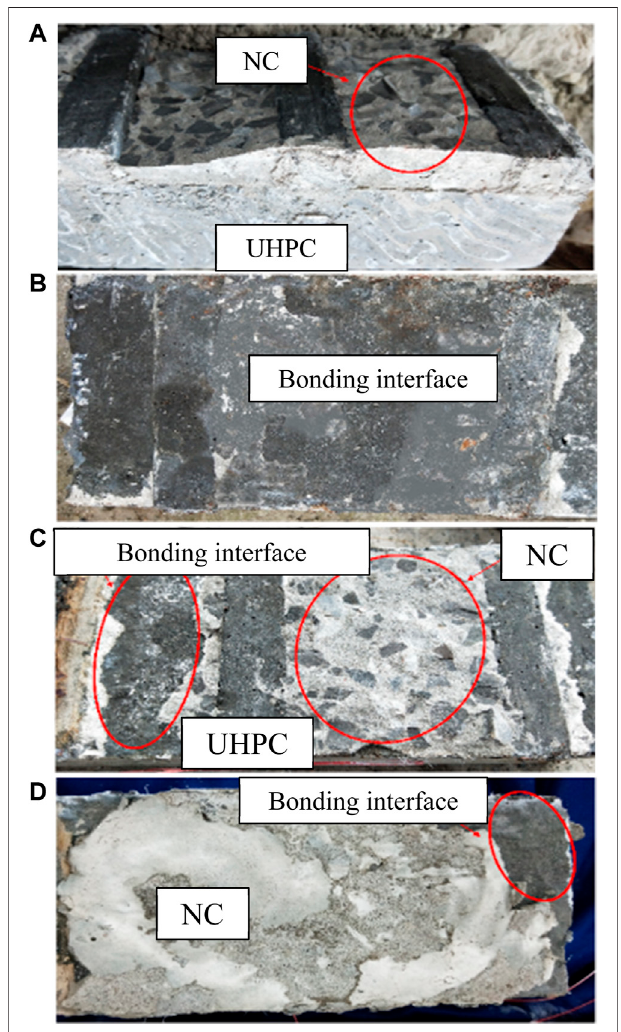
FIGURE 5 | Failure modes of specimens. (A) Type A. (B) Type B. (C) Type C. (D) Type